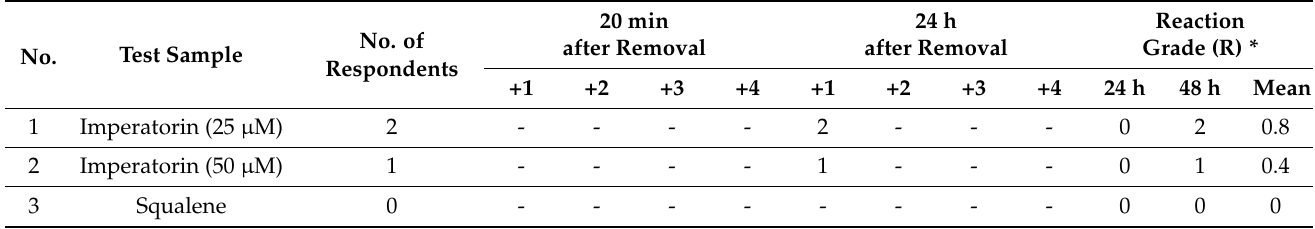
Table 1, the test substance (imperatorin) was classified as causing “no to slight irritation” in terms of primary irritation potential on human skin. Table 1. The results from the primary human skin irritation tests ( n =